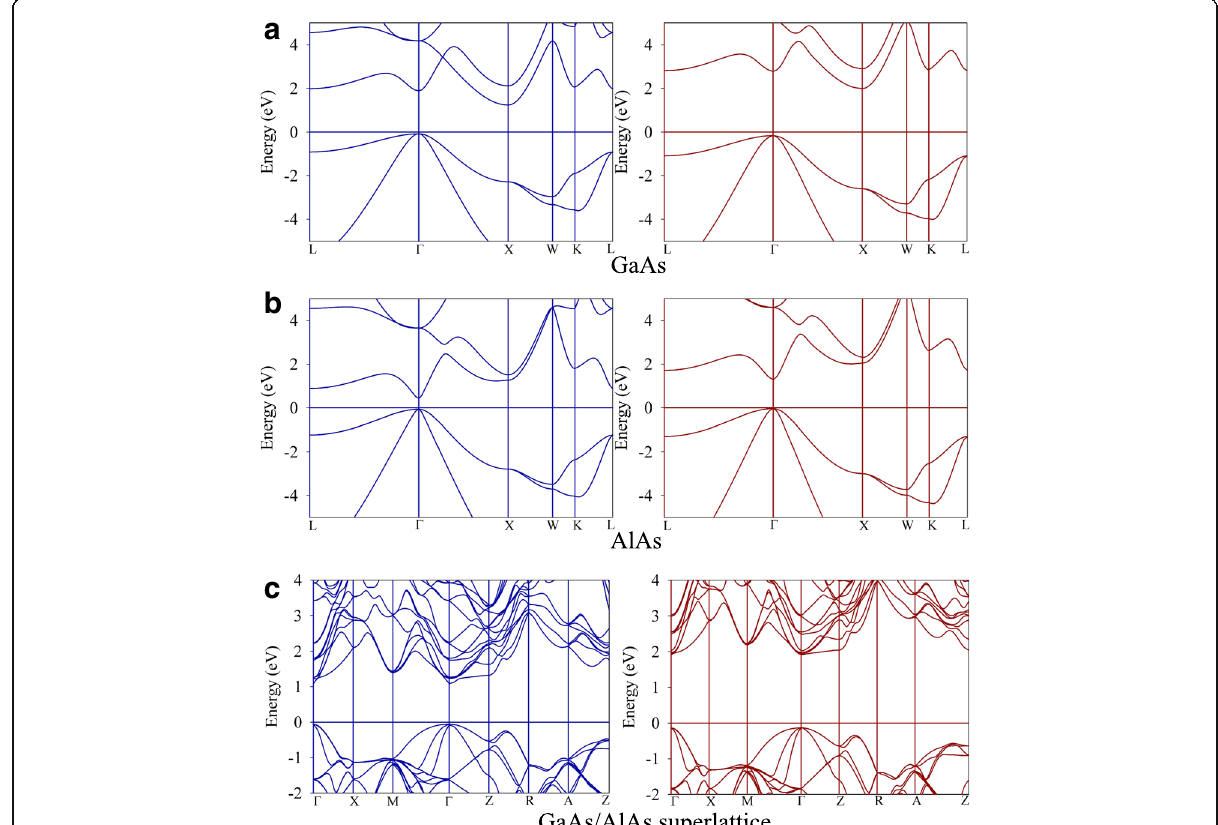
Fig. 4 The band structures of a GaAs, b AlAs and c GaAs/AlAs superlattice. The hybrid DFT values are plotted in left-hand panels and the DFT results are plotted in the right-hand